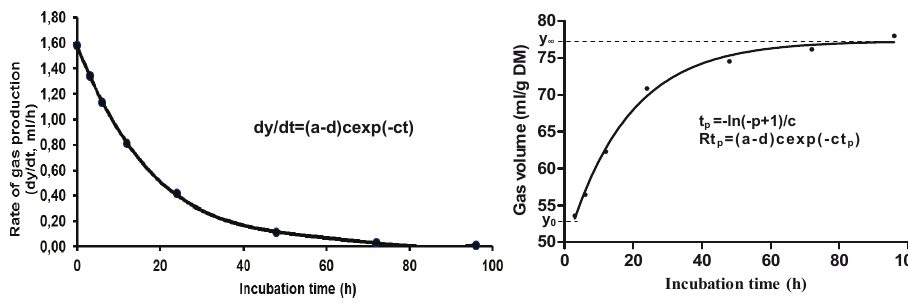
Figure 1 The behaviour of the modified Mitscherlich model on a data produced as y ∞ The behaviour of the modified Mitscherlich model on a data produced as hypothetical y=77.26(1-(77.26- hypothetical y=77.26(1-(77.26-48.84)(exp(-0.05574t))/77.26) , R 2 =0.9944 48.84)(exp(-0.05574t))/77.26), R2=0.9944 t p =-ln(-p+1)/c Rt p =(a-d)cexp(-ct p )